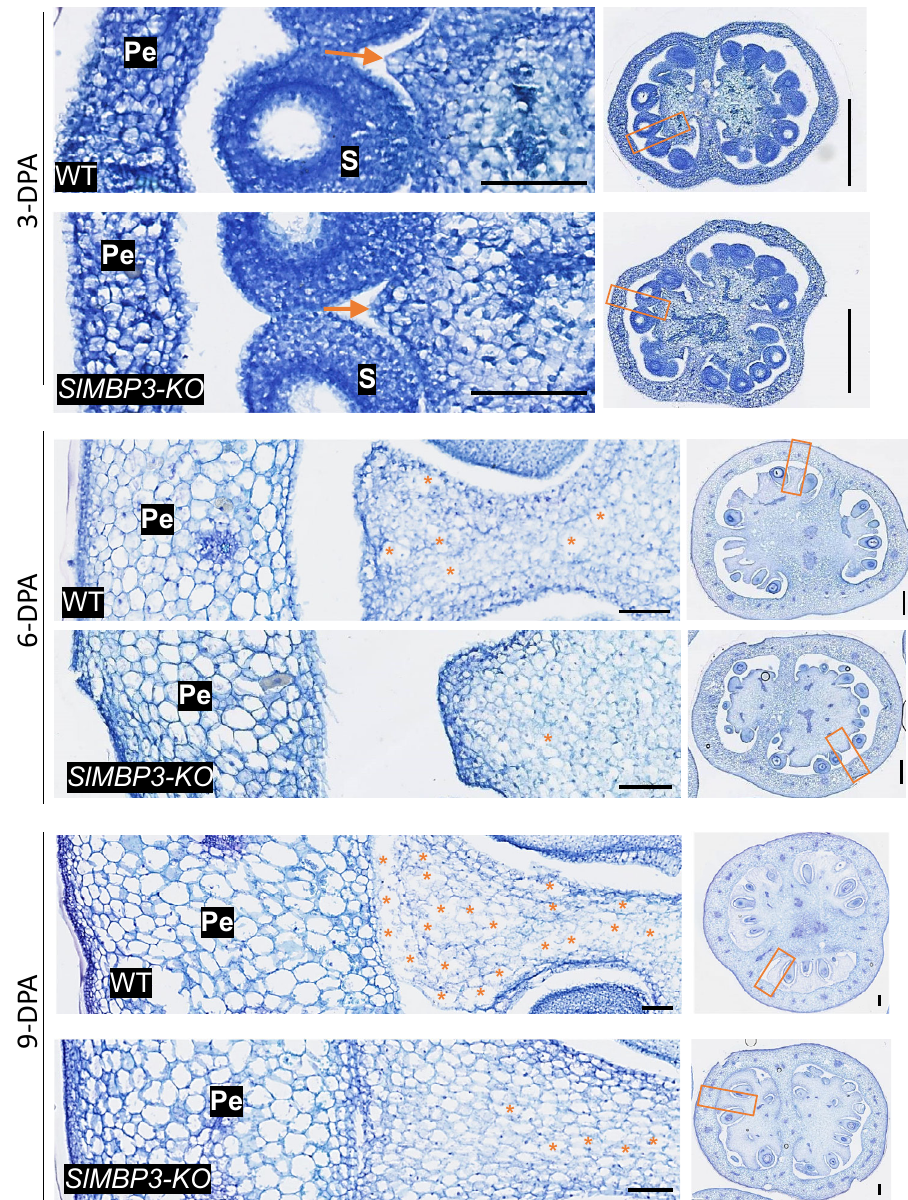
Fig. 7 Trait variation of the locular tissue cells between SlMBP3 -KO and wild type fruits. Paraf fi n cross-sections of SlMBP3 -KO and wild type fruit at early fruit development stages (3, 6, and 9 days post-anthesis (DPA)). The orange rectangles on the whole fruit cross-sections on the right are magni fi ed on the left to zoom in on the regions of interest (ROIs) of locular tissue cells used for quanti fi cation. Orange arrows indicate the sites of initiation of locular gel formation; *indicate individual over-expanded or disintegrated cells; Scale bar: 100 µ m on the left images and 500 mm on the right images; pe pericarp, s seed. Six independent experiments were performed, giving similar